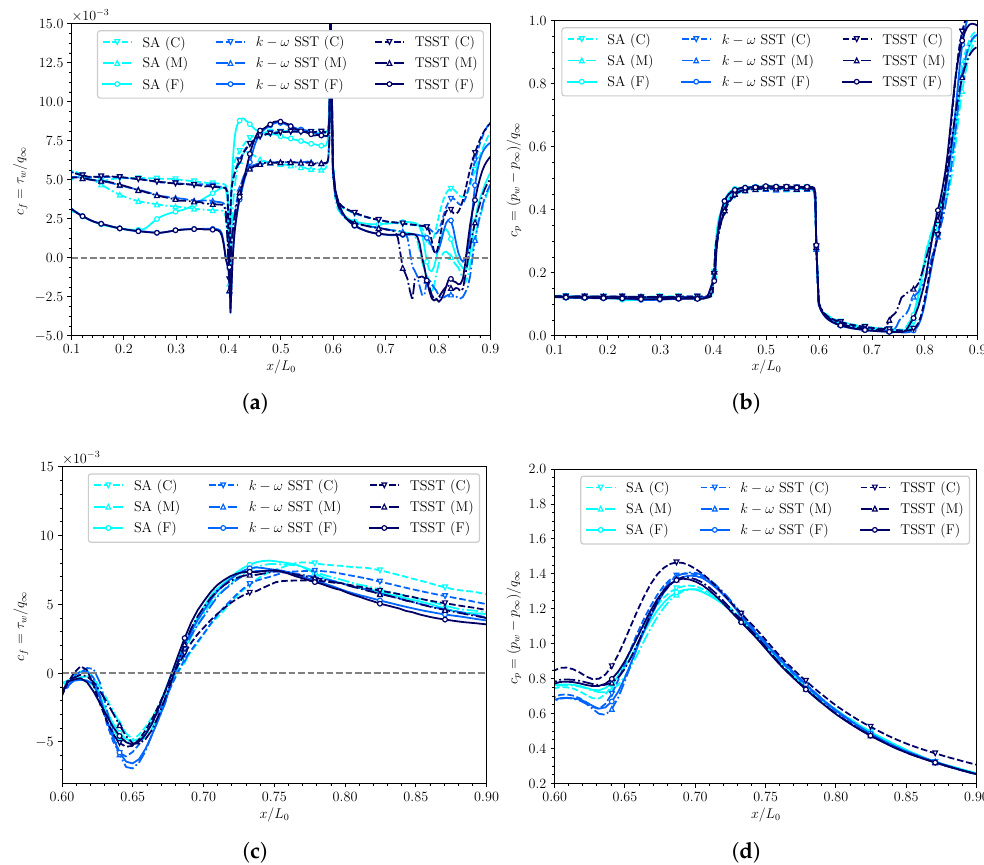
Figure 7. Friction and pressure coefficients trend along with the bottom ramps body and channel surface as a function of the turbulence model and the mesh refinement. ( a ) Friction coefficient (bottom surface); ( b ) Pressure coefficient (bottom surface); ( c ) Friction coefficient (top surface); ( d ) Pressure coefficient (top